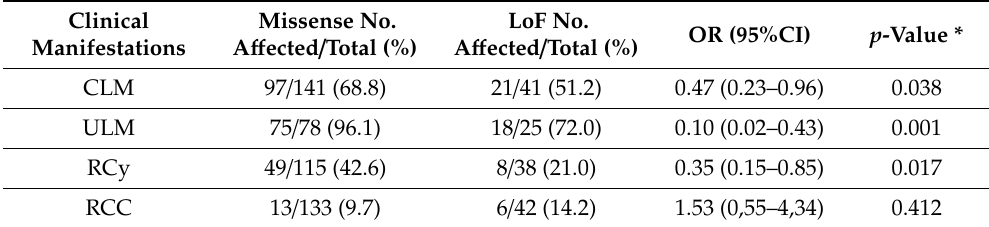
Table 2. Phenotype / Genotype associations.